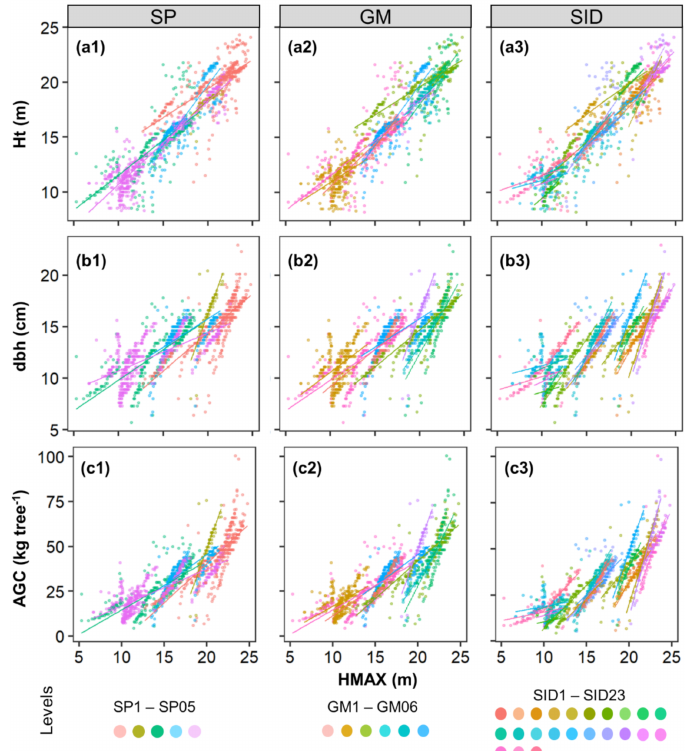
Figure 6. Scatterplots of the lidar-measured maximum height (HMAX) against the field-measured height (Ht), diameter at 1.3 m above the ground (dbh), and aboveground carbon (AGC) (a, b and c, respectively). Colors represent the levels of species (SP) ( a1 , b1 , c1 ), Genotype (GM) ( a2 , b2 , c2 ), and Stand (SID) ( a3 , b3 , c3 ) used as random-e ff ect variables in the linear mixed-e ff ect models. Plotted-lines were fitted to each group to better demonstrate the di ff erent patterns for each